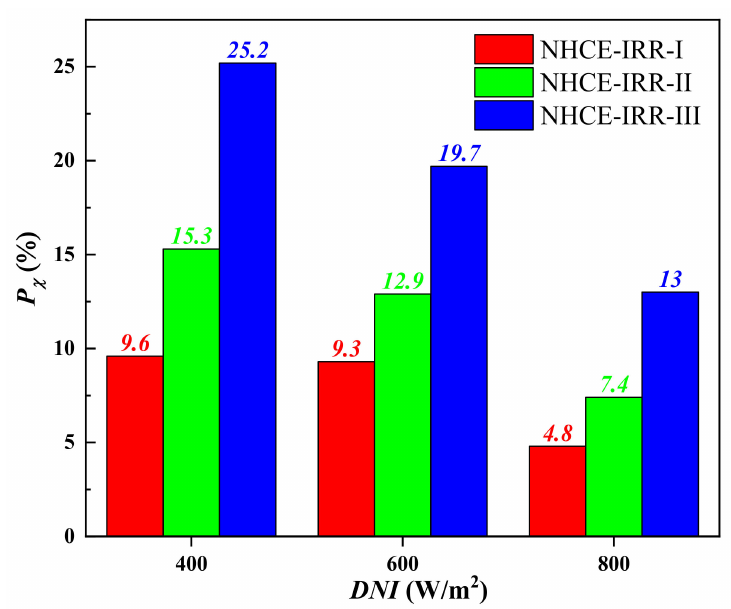
Figure 14. Percentage of exergetic e ffi ciency enhancement of NHCEs versus